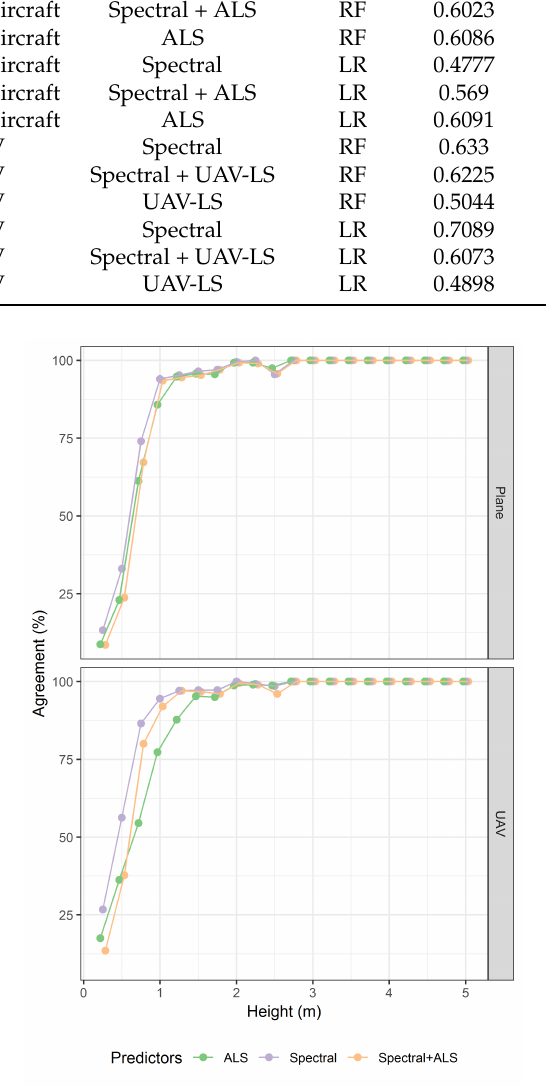
Figure 6. Agreement values for the independent validation dataset for trees within each height class. Each datum shows the mean of the agreement value for both the combined RF and LR